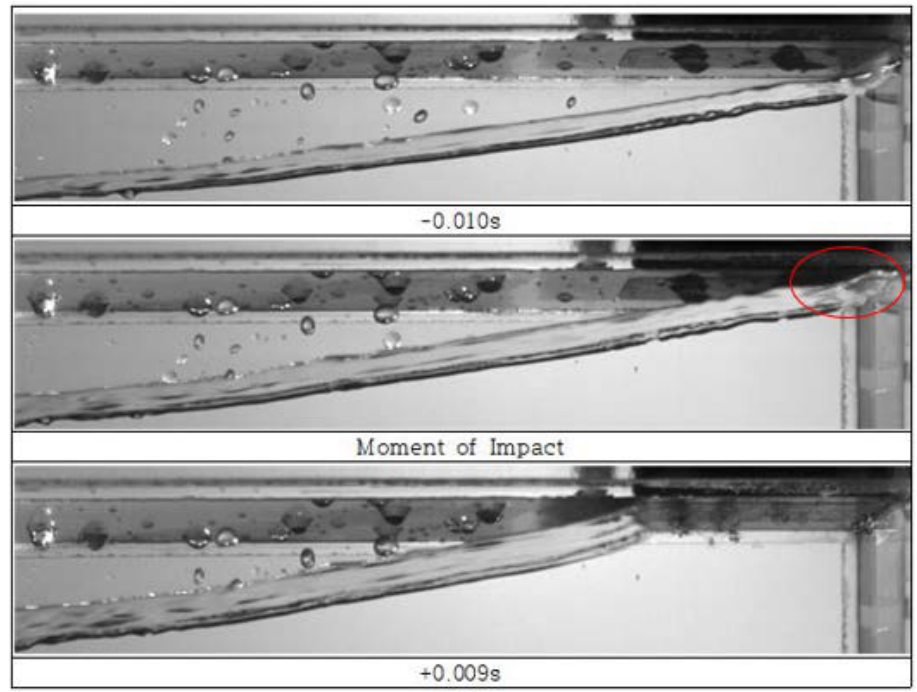
Figure 15. Snapshots at First Impact: ROLL (Wet).